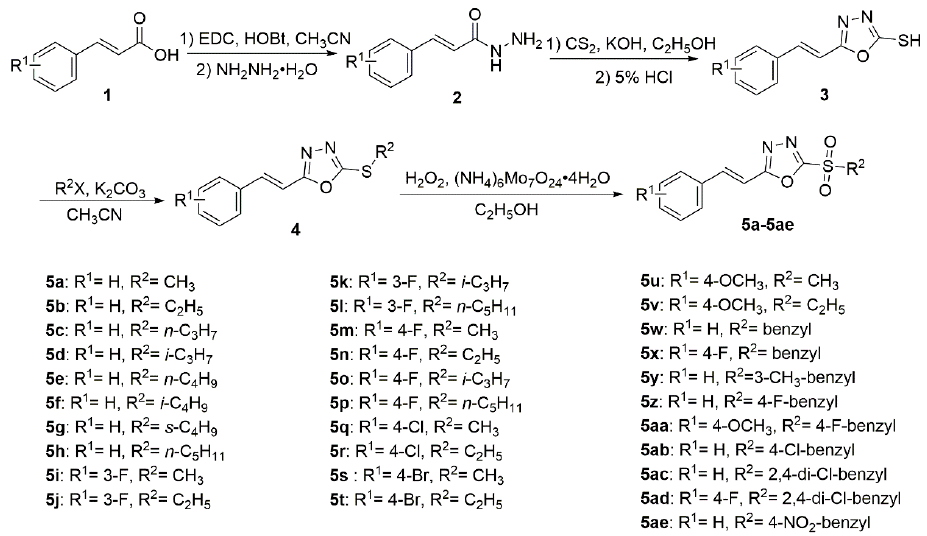
Scheme 1. Synthesis of the target compounds 5a – 5ae .